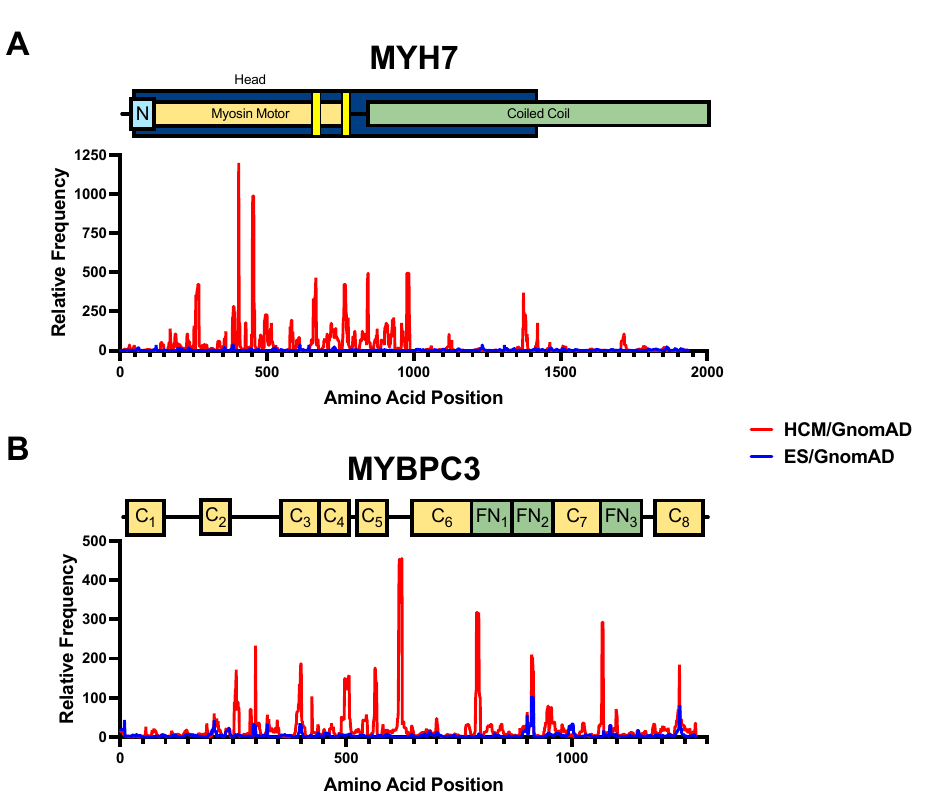
Figure 4. ( A ), Amino acid-level signal-to-noise analysis of MYH7 variants for both HCM cases (red) and ES-identified variants (blue), compared with variants identified in the gnomAD cohort. ( B ), Amino acid-level signal-to-noise analysis of MYBPC3 variants for both HCM cases (red) and ES-identified variants (blue), compared with variants identified in the gnomAD cohort. Functional domains of MYH7 and MYBPC3 are depicted. N, N-terminal domain; Cx, immunoglobulin-like domain; FNx, fibronectin domain; highlighted yellow regions, actin binding sites.